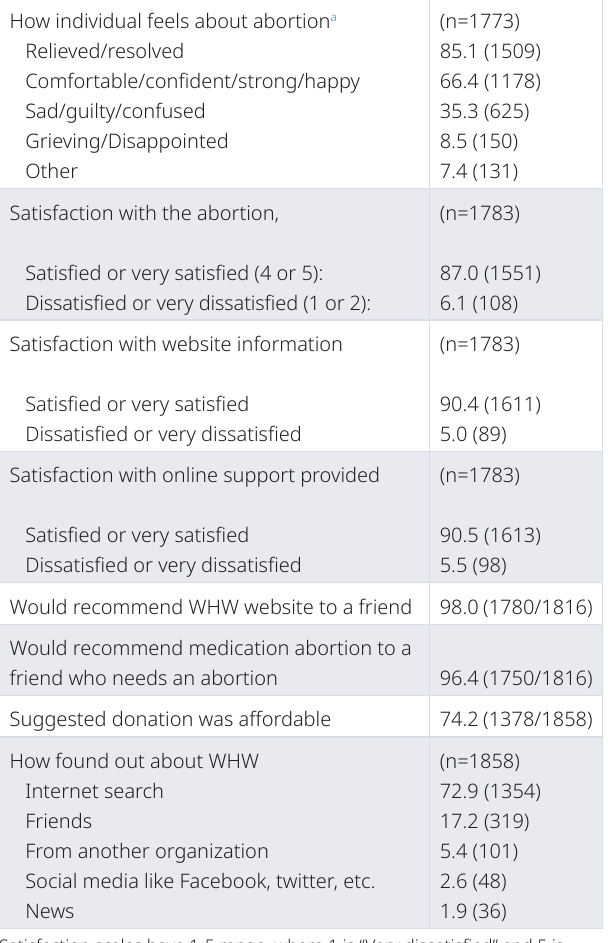
Table 3. Self-reporting of side effects among individuals who took MA pills received from WHW and who completed online evaluation form %